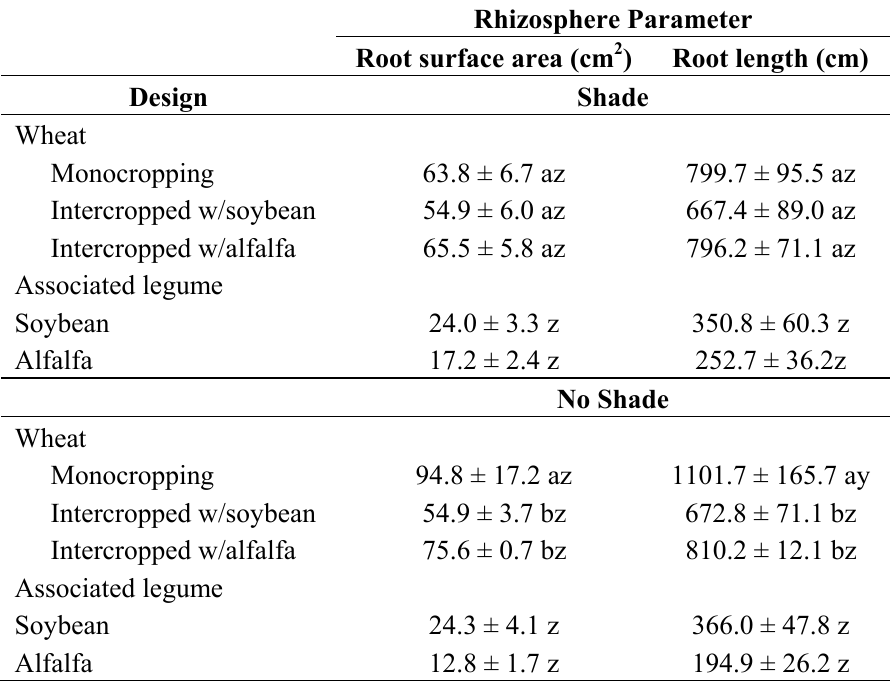
Table 2. Root growth parameters (root surface area and root length) for wheat (in moncropping or intercropped with soybean or alfalfa), soybean and